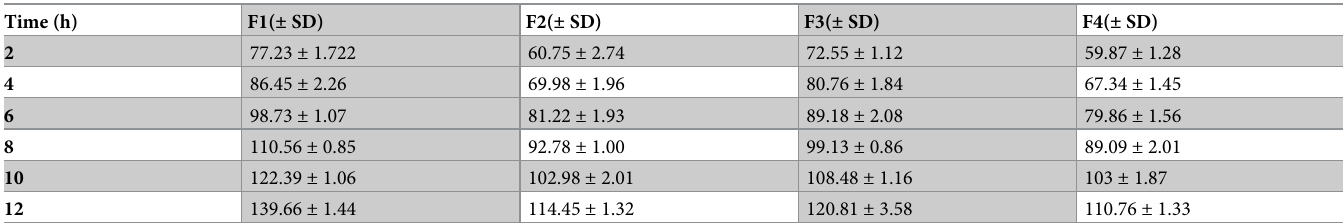
Table 5. Cumulative swelling index (%) of propranolol HCl floating tablets.